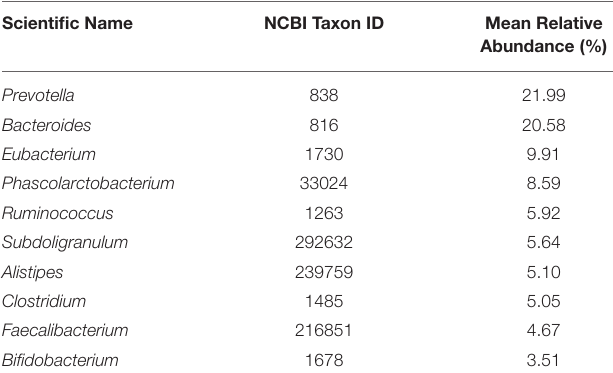
TABLE 2 | Ranking of top 10 intestinal microbiota with T1D (Genus).